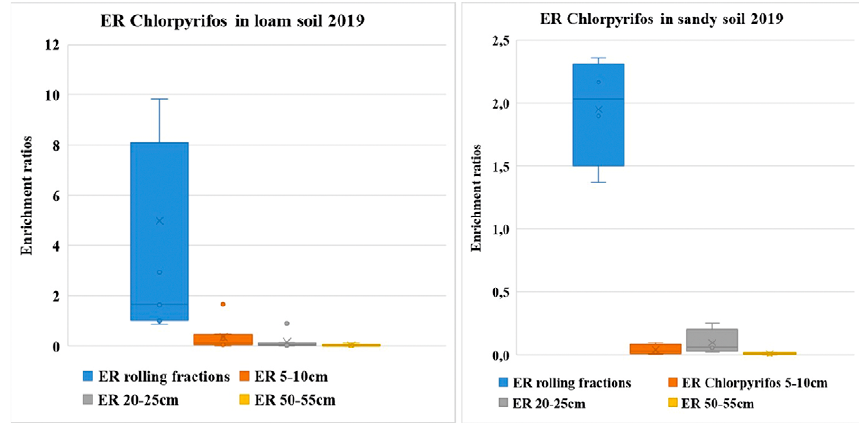
Figure 10. Enrichment of chlorpyrifos in texture of loam and sandy soil in 2019